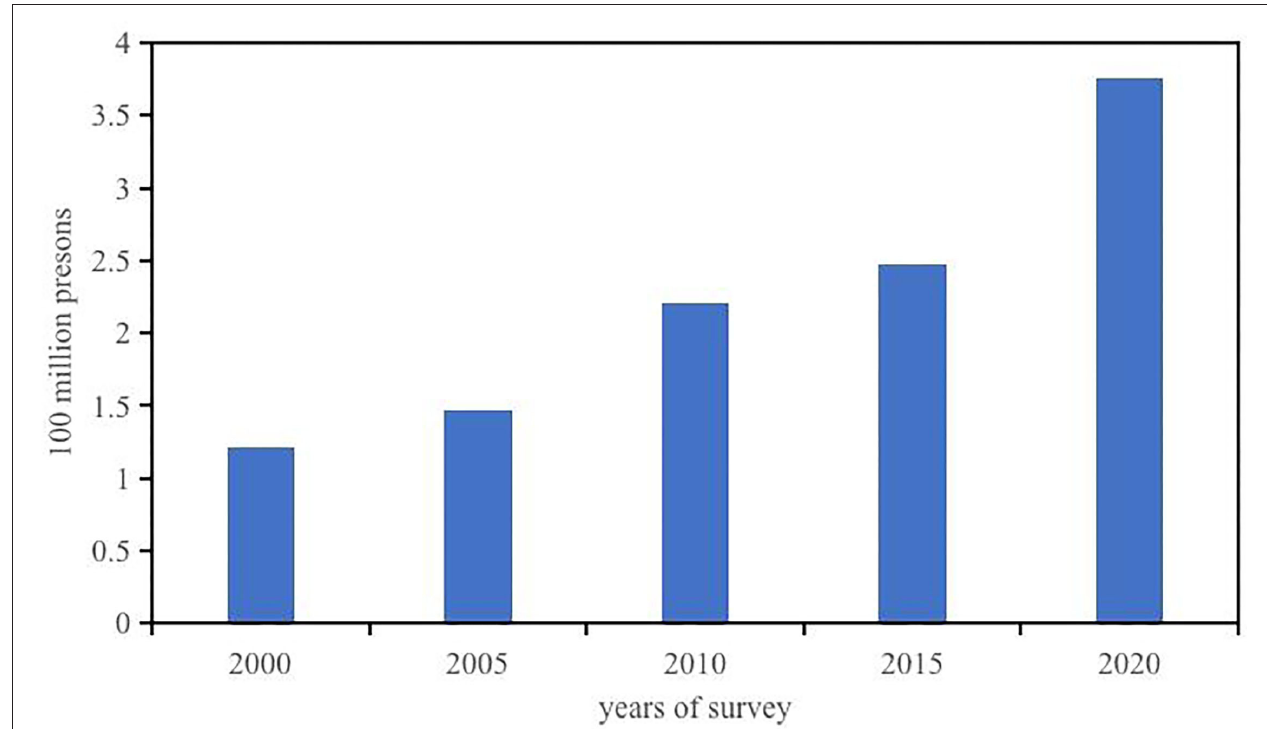
FIGURE 1 | The changing trend of migrants in China. Data sources from National Bureau of Statistics of